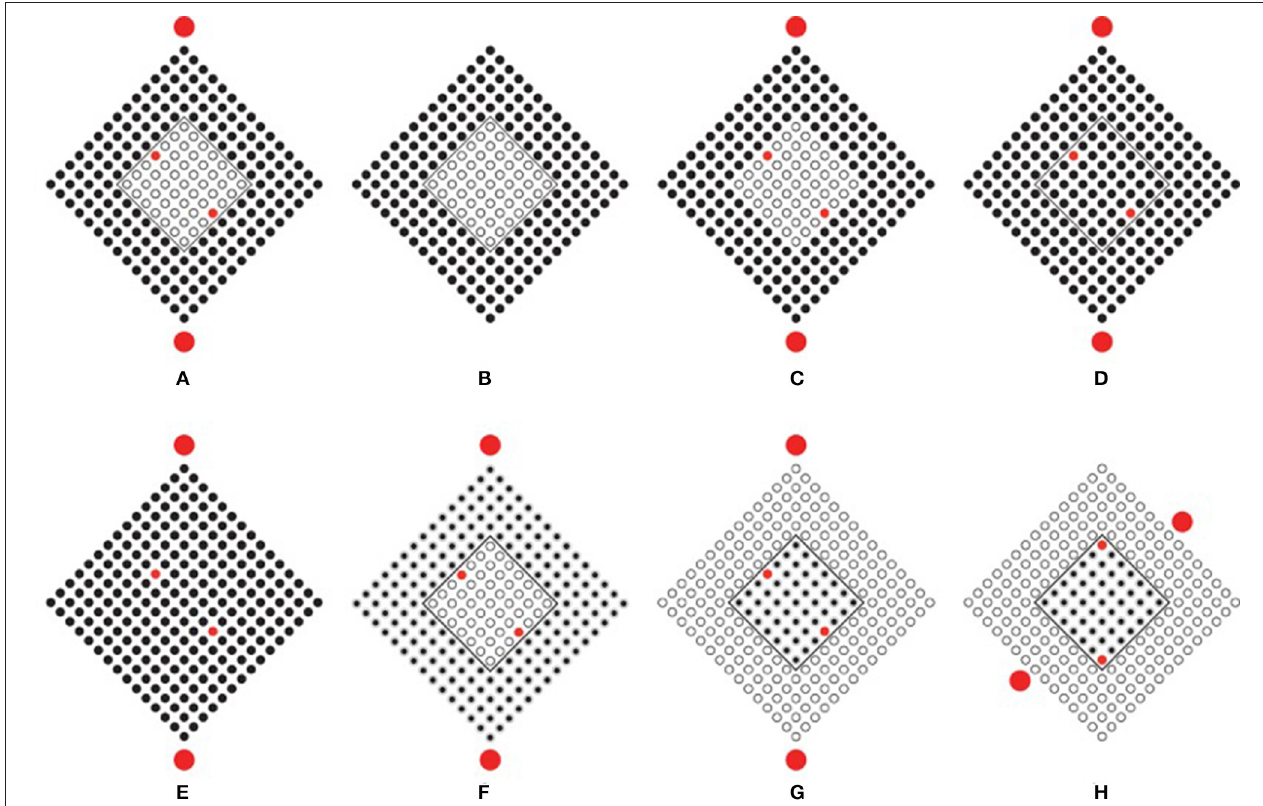
FIGURE 9 | In spite of the belongingness of all circles to the same large array (see B as a control), the presence of accentuation along different directions reorganizes the two nested arrays according to the accent (vertical for the large array and oblique for the inset one in A,C,D,E,F,G, or oblique for the large array and vertical for the inset one in